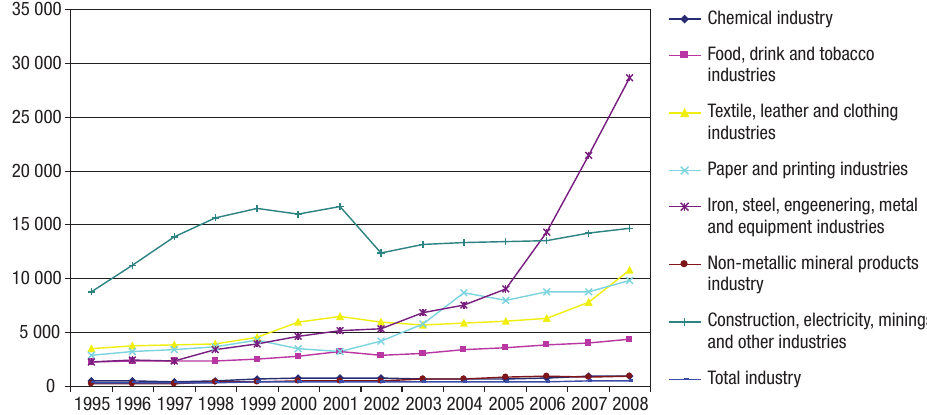
Fig. 10. Energy productivity of Lithuania‘s industrial sectors during 1995–2008 Source : Data from EUROSTAT, index calculated by authors (energy productivity is as a ratio of output per energy consumption, an input; where energy productivity = Gross Value Added, EUR / Energy consumption,